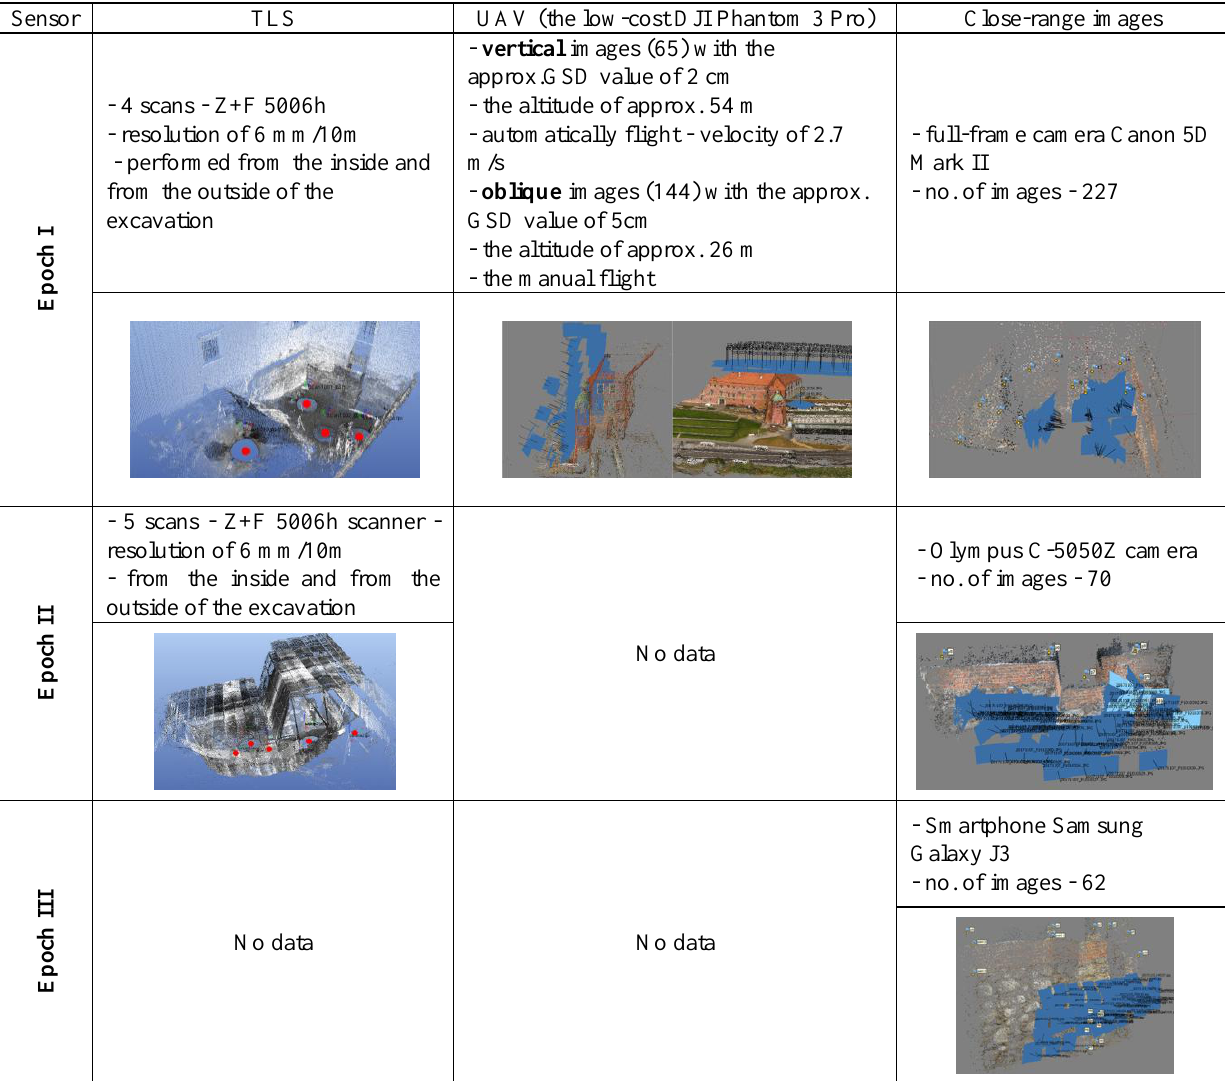
Table. 2. The overview of used equipment with defined measurements parameters control and check points. Red colour - points, the blue rectangle Measurements were performed using the Leica 1201+ total - tested area. The photogrammetric control check points were station which allows to measure angles with 1” and the reflector also defined (Fig. 2A) around the analysed excavation and its distance measurement with 1 mm +1.5 ppm. The positioning accuracy for the 1-order control equals to 2 mm. The geodetic closest surroundings (Fig. control was measured in two epochs (I and II). Displacements of reference points were not noticed, after the analyses and comparison of positions of points in both measurement epochs. The accuracy of determination of points of the photogrammetric control, not worse than 3 mm was obtained.